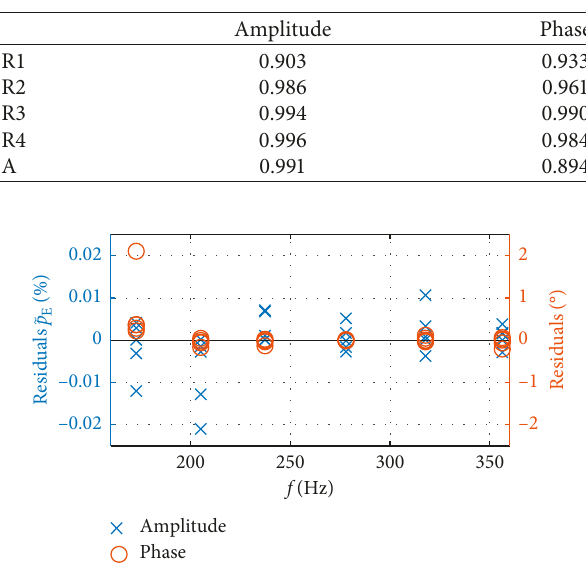
Figure 10: The RSI second harmonic frequency. Pressure amplitudes are normalized to the potential energy. The error bars represent the uncertainty from calibration and the experimental repeatability of the amplitudes. Table 3: Goodness of fit R 2 .